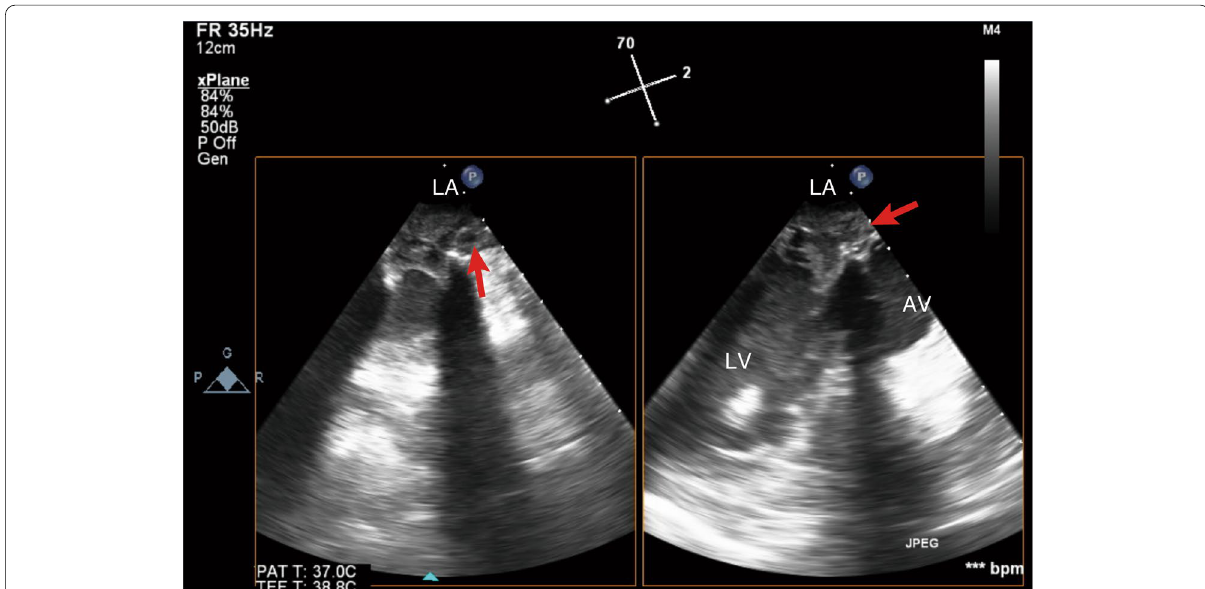
Fig. 3 Mid-esophageal mitral commissural view (left) and long axis view (right). The prosthetic mitral valve occluded by a left atrial thrombus (arrow) was observed on postoperative day 1, after the initial mitral valve replacement by transesophageal echocardiography performed in the ICU. AV, aortic valve; LA, left atrium; LV, left ventricle